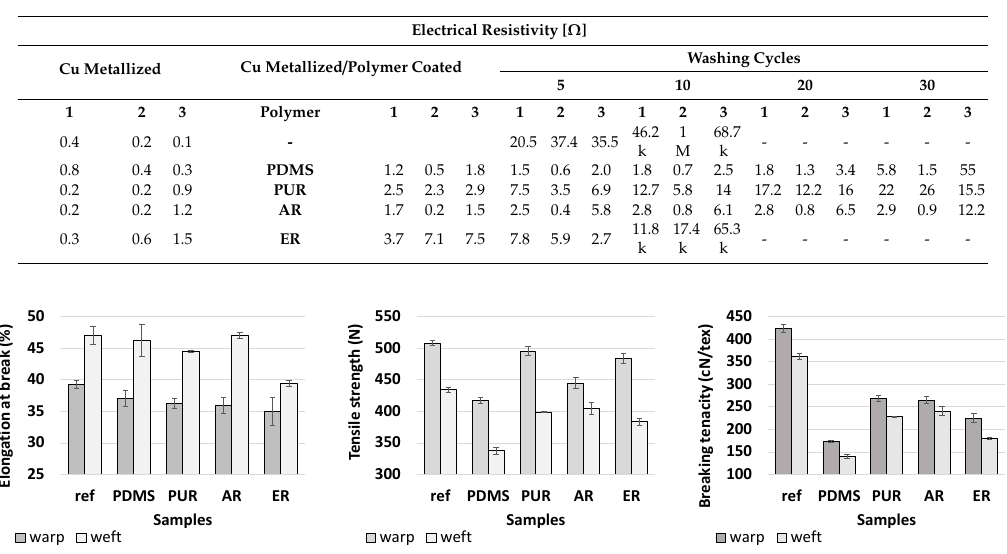
Table 3. Electrical resistivity before and after washings.